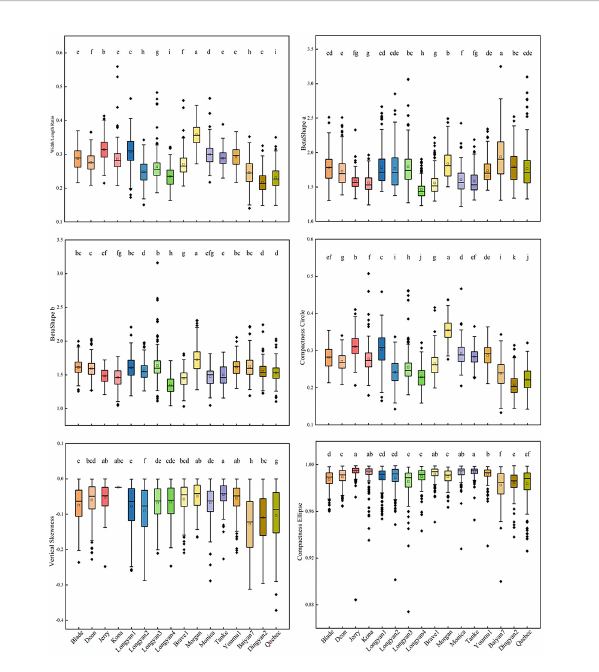
FIGURE 4 Shape features of 16 Avena sativa L. cultivars. Note: Different lowercase letters represent signi fi cant differences between cultivars with the same feature (P<0.05).